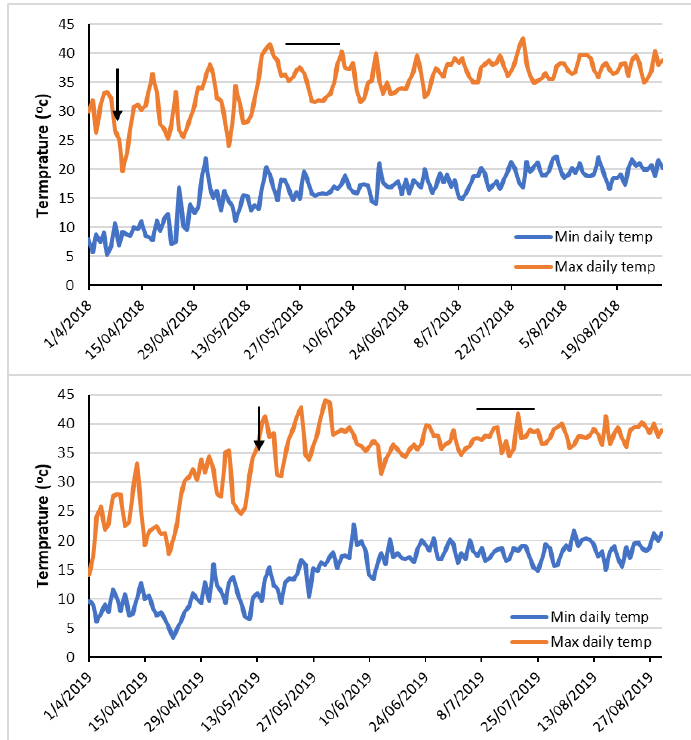
Figure 2. Daily minimum and maximum air temperatures measured at the Hula experimental site during the 2018 (top) and 2019 (bottom) seasons. Arrows indicate date of sowing and horizontal bars indicate heading periods across treatments and genotypes.